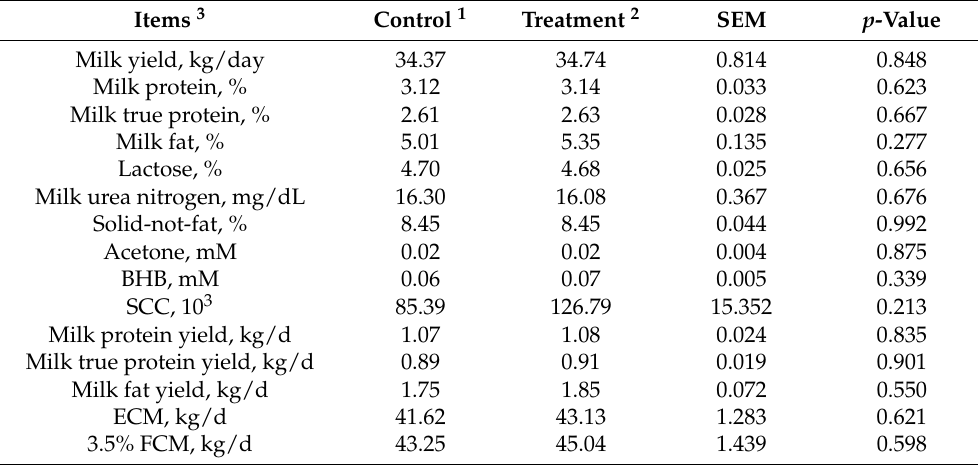
Table 7. Effects of noni meal on milk yield and composition in Holstein dairy cows.